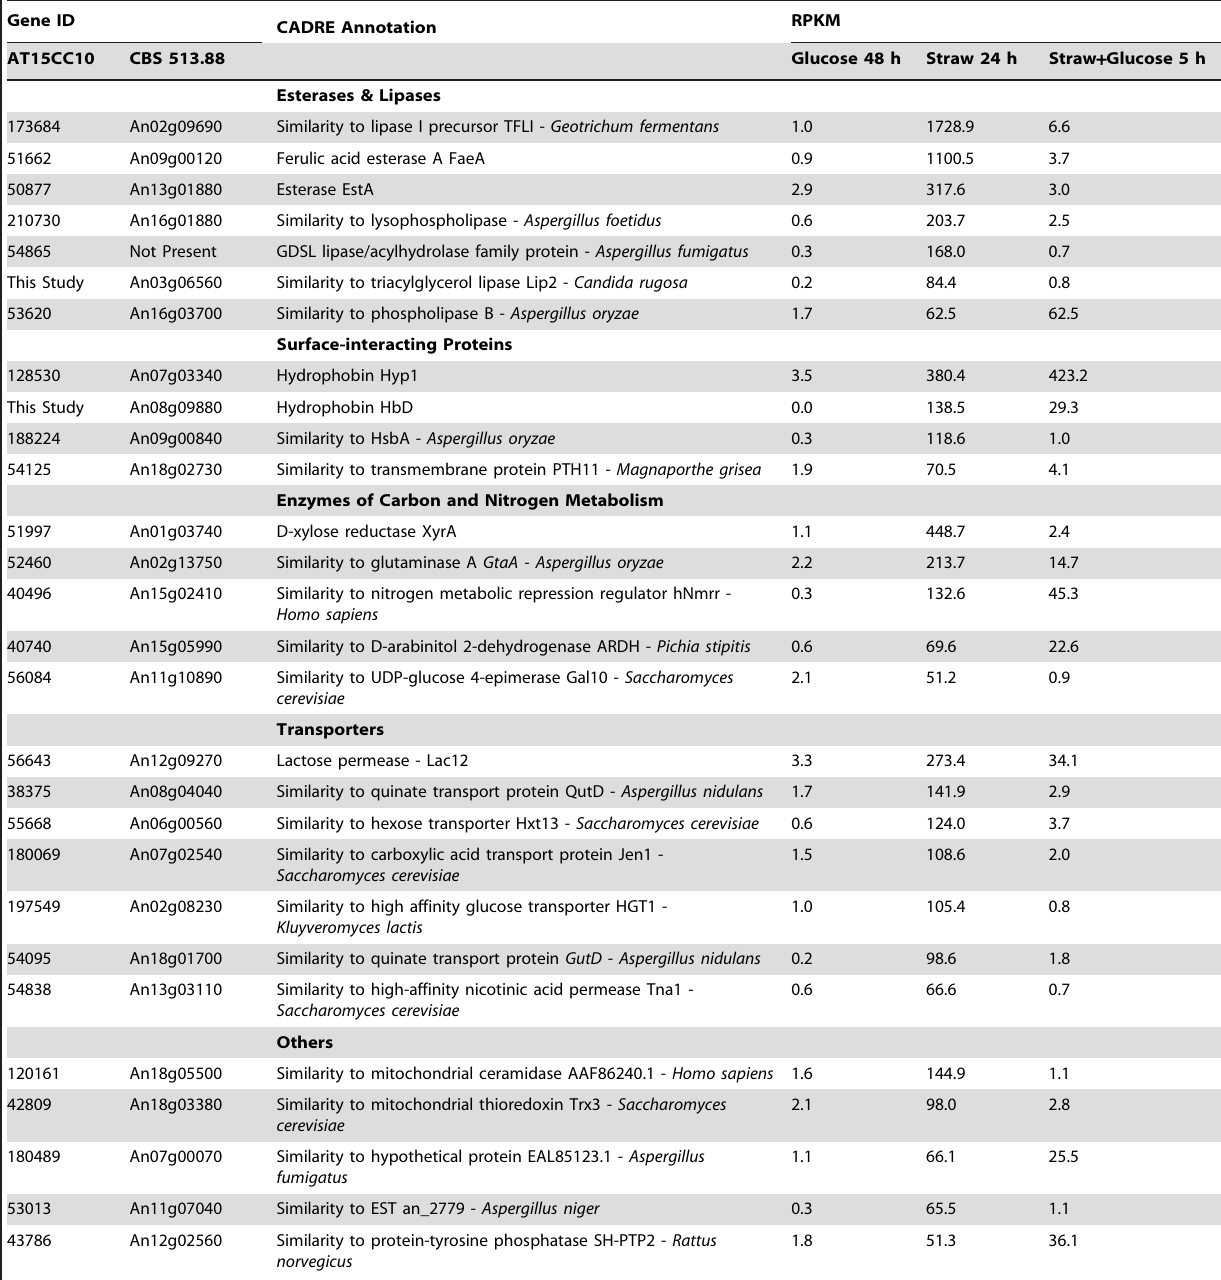
Table 2. Straw-induced non-CAZy